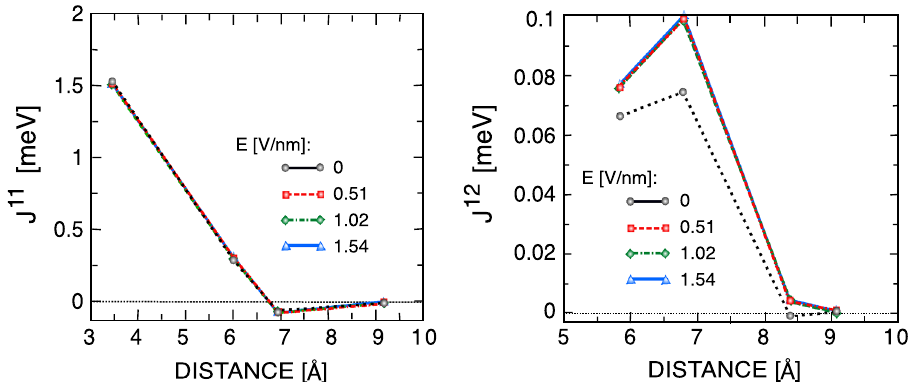
Figure 7. (Color online) Total intralayer (left) and interlayer (right) exchange parameters of bilayer CrCl 3 as a function of electric field. A positive value indicates FM contribution, and a negative value indicates AFM contribution.